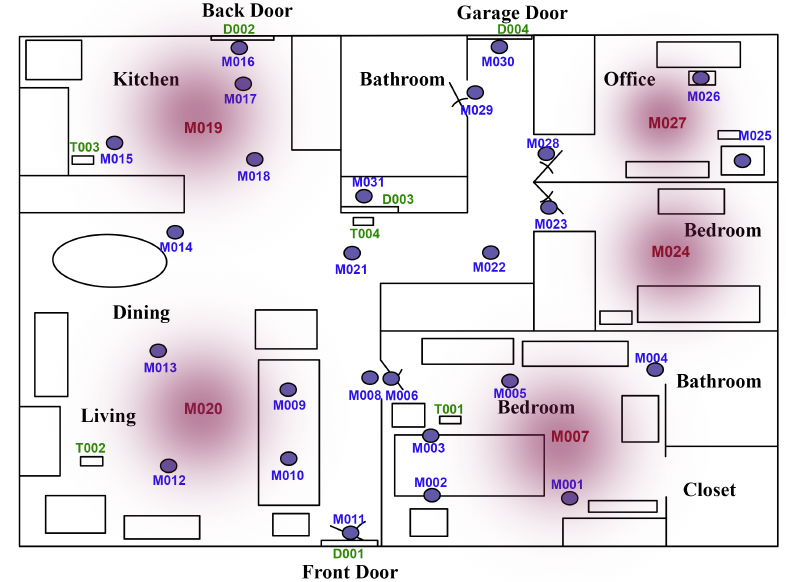
Figure 5. Aruba CASAS floor